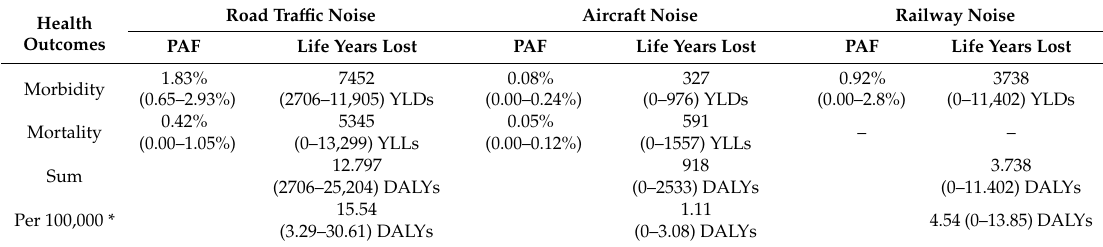
Table 6. Burden of disease due to ischemic heart disease attributable to tra ffi c noise in Germany, 2016 (95% CI in